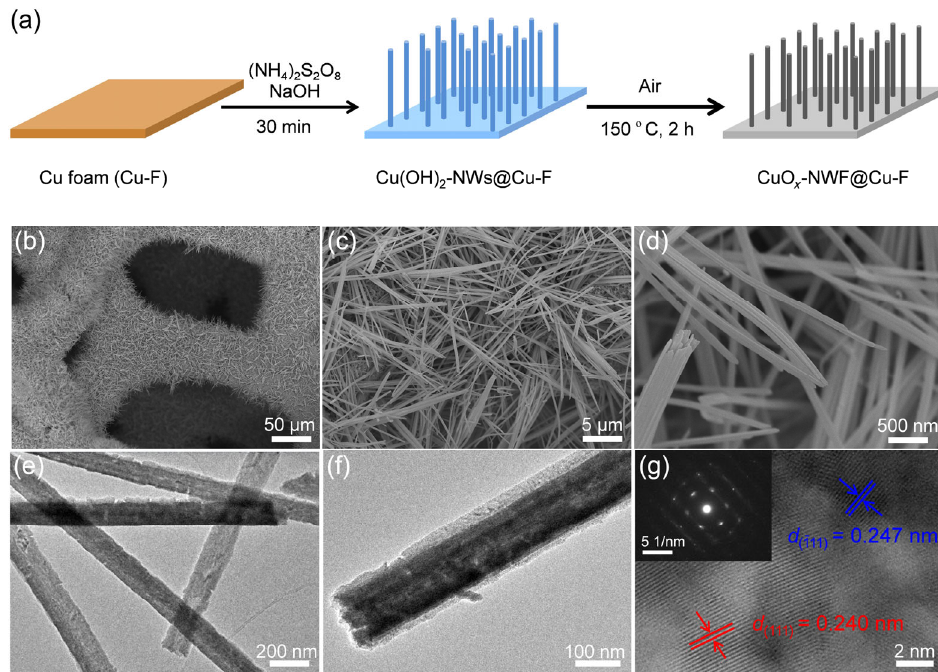
Figure 1 Morphological characterizations of CuO x -NWF@Cu-F. (a) Schematic illustration of the preparation process of CuO x -NWF@Cu-F. (b)–(d) SEM images of CuO x -NWF@Cu-F at different magnifications. TEM ((e) and (f)) and HRTEM (g) images of as-prepared CuO x nanowires. The lattice fringes ＿ in (g) are assigned to the (1 11) planes of CuO and (111) planes of Cu 2 O, respectively. The corresponding SAED pattern in the insert of (g) reveals the crystalline nature of as-prepared CuO x